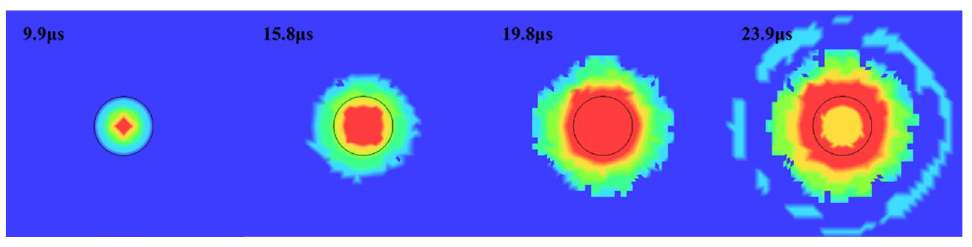
Figure 6. Explosive detonation